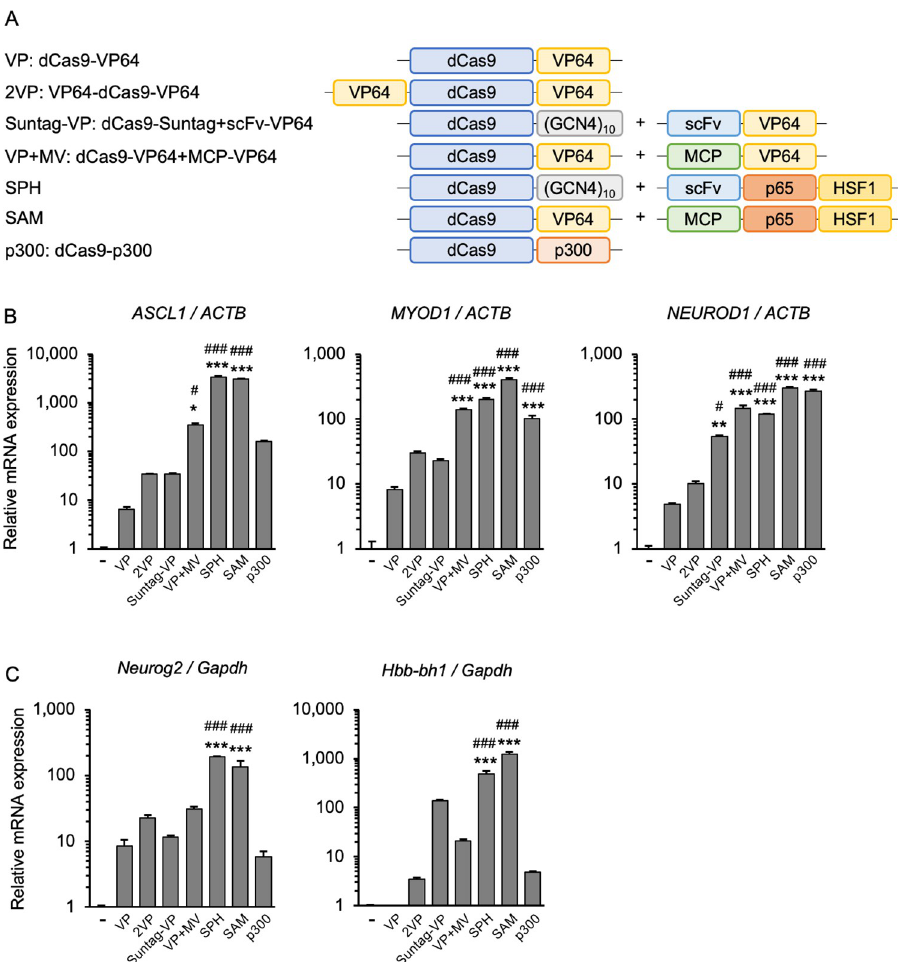
Fig 1. Functional comparison of various CRISPRa approaches to activate endogenous genes in human and mouse cells. (A) Schematic diagrams of the CRISPRa systems used in the comparative studies. (B) Expression analysis of three endogenous genes in human HEK293T cells. SAM and SPH induced the expression of ASCL1 and MYOD1 better than did the other systems. SunTag-VP, VP+MV and p300 similarly activated ASCL1 and MYOD1 , but p300 activated NEUROD1 stronger than did the VP systems. (C) Expression analysis of two endogenous genes in mouse Neuro-2a cells. SAM and SPH induced both Neurog2 and Hbb-bh1 better than did the other systems. For activation of both human and mouse genes, increasing the number of VP64s, as in 2VP, Suntag-VP, and VP+MV, improved the efficiency compared with VP. Error bars indicate the mean ± SE (n = 3). Statistical analysis was performed using one- way ANOVA with Tukey’s multiple comparisons test. �� , P < 0.01; ��� , P < 0.005 vs. non-induced control, # , P < 0.05; ### , P < 0.005 vs.